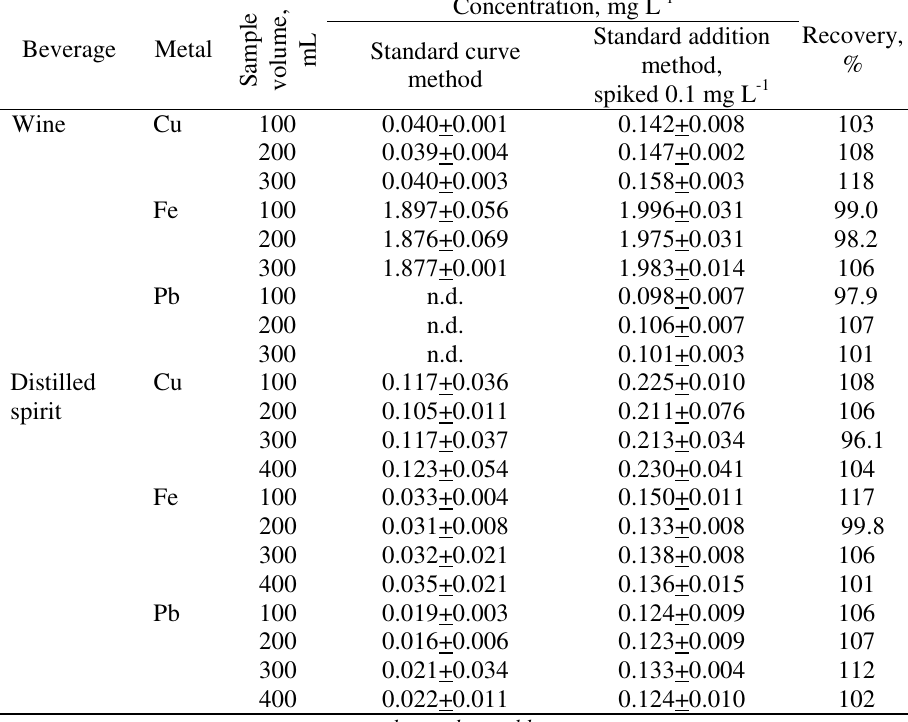
Table 4. Effect of sample volume on recovery of Cu, Fe and Pb determination ( n = 3)